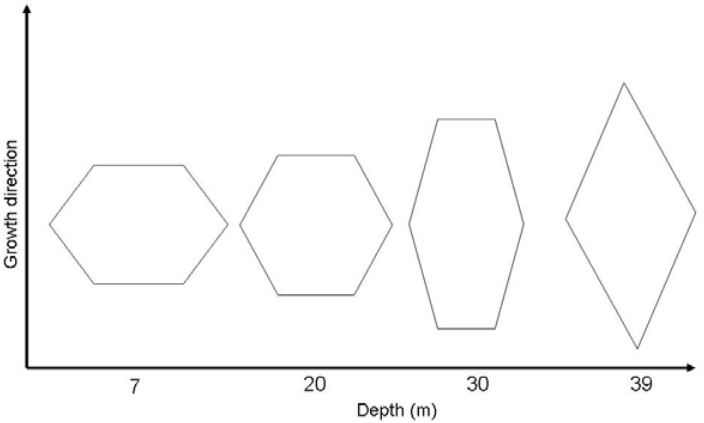
Figure 4. Shape of the nacre tablet as a function of depth, in relation to the shell growth